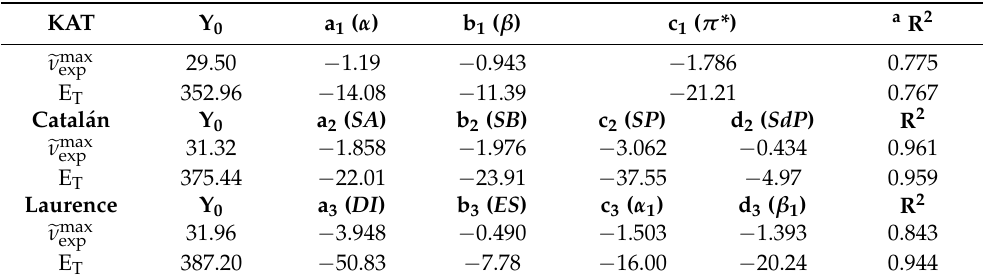
Table 3. Resulting coefficients ( × 10 3 cm − 1 ) from the multiparametric regression analysis of ν ~ max exp and E T of the BZCH as a function of the KAT, Catal á n, and Laurence (Equations (1)–(3)) solvent scales.